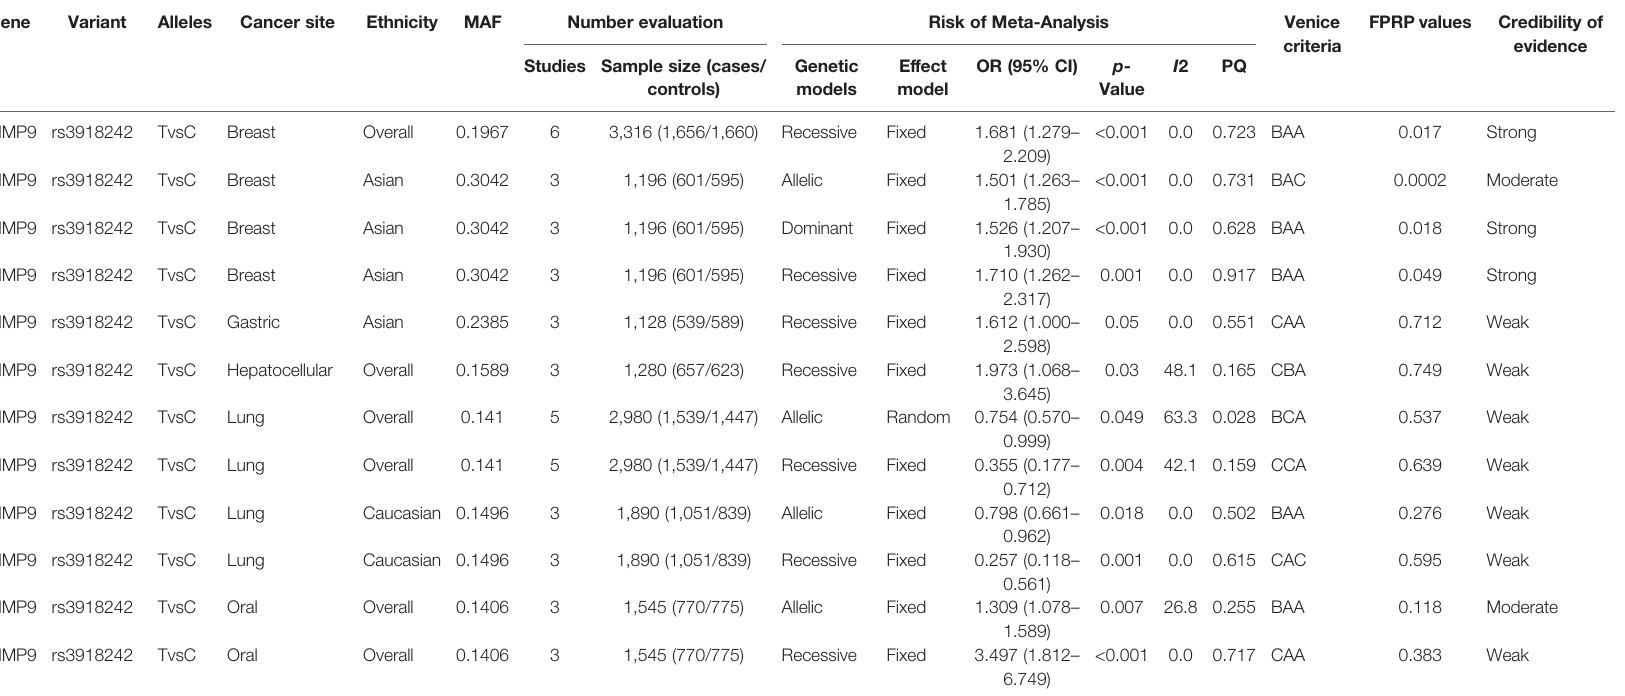
Allelics: minor allelic (bold) vs. major allelic. Venice criteria grades are for amount of evidence, replication of the association, and protection from bias. The prior probability of FPRP is 0.05, and the FPRP level of noteworthiness is 0.20. C, cytosine; T, thymine; OR, odds ratio; MAF, minor allelic frequency in control; FPRP, false-positive report